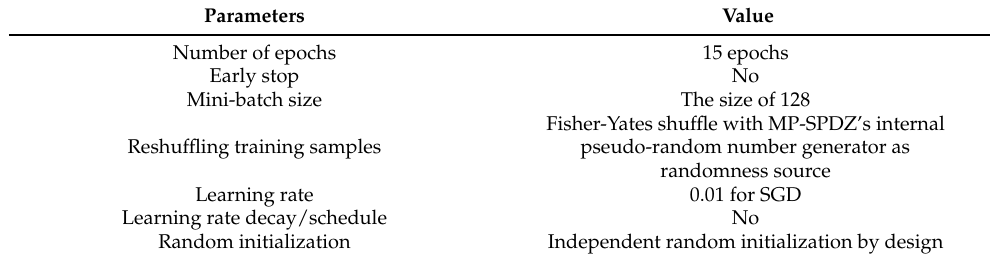
Table 4. Hyperparameter Settings.